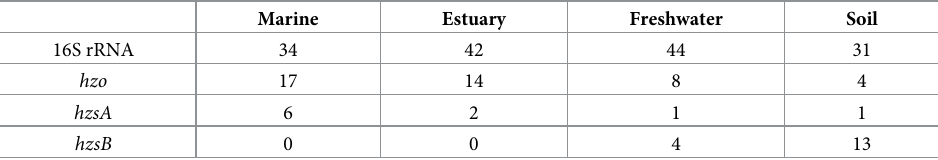
Table 1. Number of collected papers with respective marker genes in each habitat.